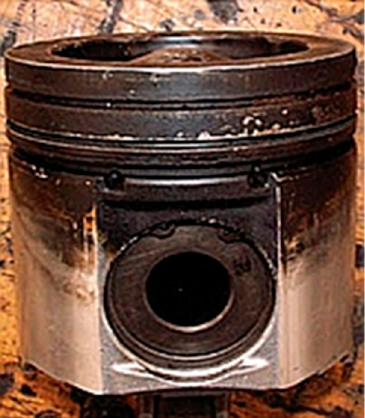
Figure 1. Effects of the “wet stacking” phenomenon [5]. Figure 1. E ff ects of the “wet stacking” phenomenon